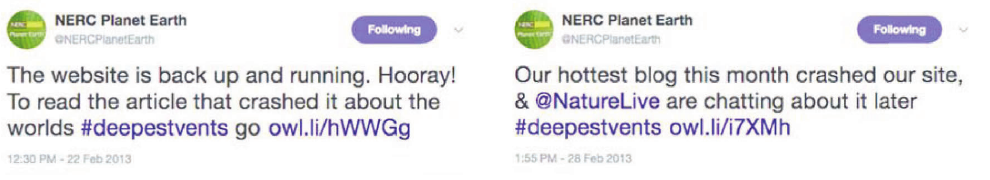
Figure 3B: Examples of evidence for ‘significance’ of impact from engagement with traditional media, consistent with our specific goal of ‘generating curiosity about science’: admission by our funder that their website was crashed by increased traffic to a background article about our research, resulting from BBC news coverage of our fieldwork in February